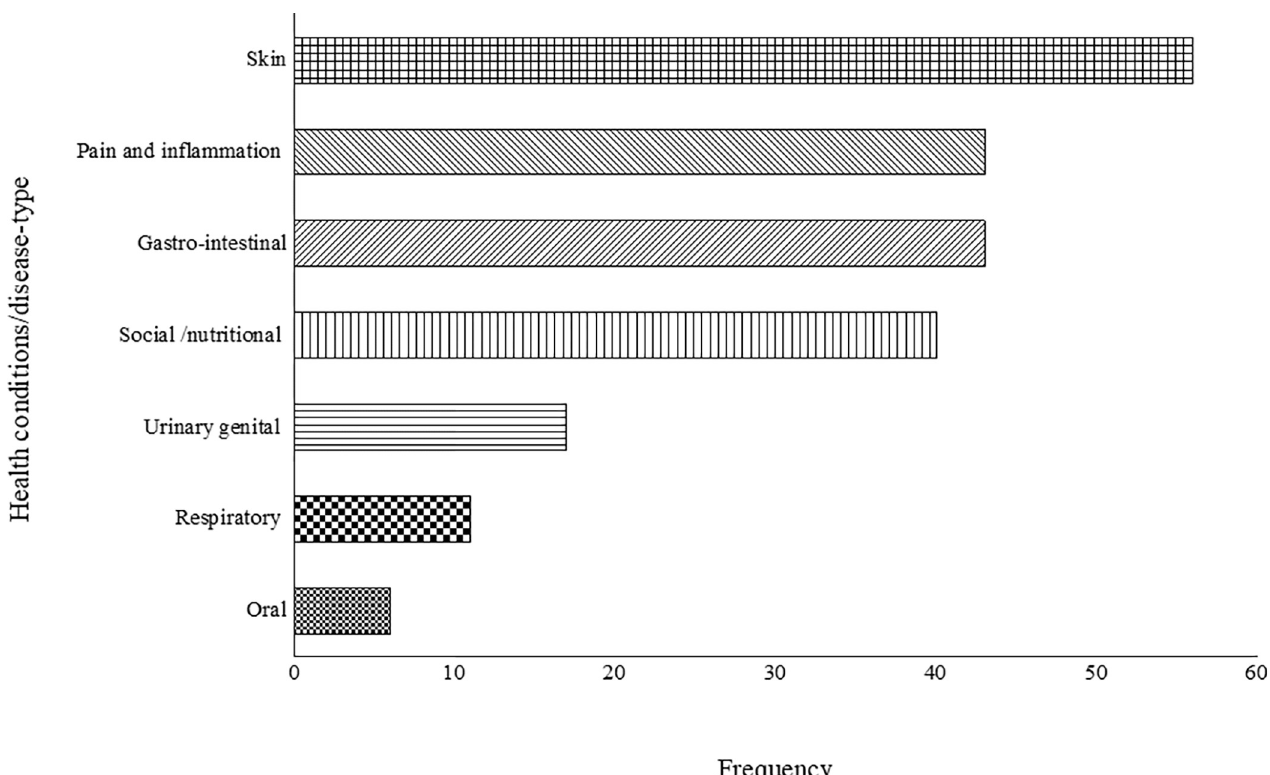
Fig 4. The range of childhood diseases treated and managed by the participants in Ngaka Modiri Molema and Bojanala districts of North West Province, South Africa.